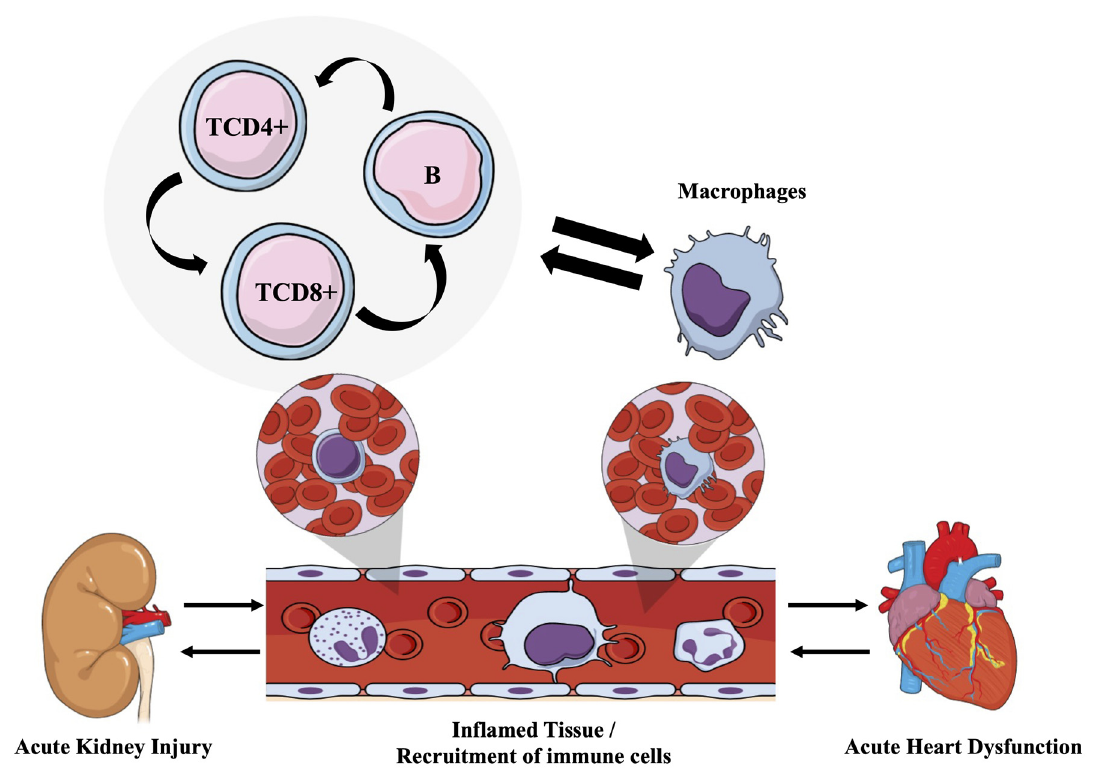
Figure 7. Activation of macrophage and T and B lymphocyte populations induced by renal I/R. I/R induces AKI, producing a local inflammation in the kidney which leads to the recruitment and activation of immune cells such as T and B lymphocyte and macrophages in distinct proportion in the renal tissue. As part of the SCR-3 scenario, the systemic inflammatory process causes alterations in the cardiac tissue where the same cells participate in this injury to the heart but to a lesser degree.